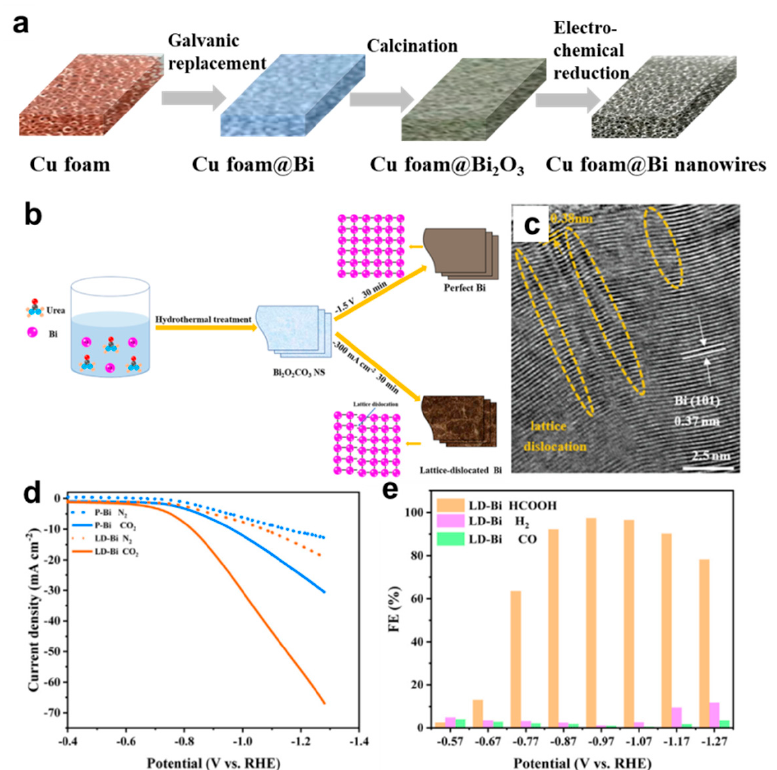
Figure 9. ( a ) Illustration of the synthesis of Cu foam@Bi nanowires. ( b ) Synthesis schematic and ( c ) HRTEM image for Bi nanosheets with rich dislocations. ( d ) Linear sweep voltammetry curves of perfect Bi (P-Bi) and lattice dislocated Bi nanosheets (LD-Bi) in a gas − saturated 0.5 M KHCO 3 solution. ( e ) FE of HCOOH, H 2 , and CO for defective Bi nanosheets. Reproduced with permission [64]. Copyright 2022, Elsevier.